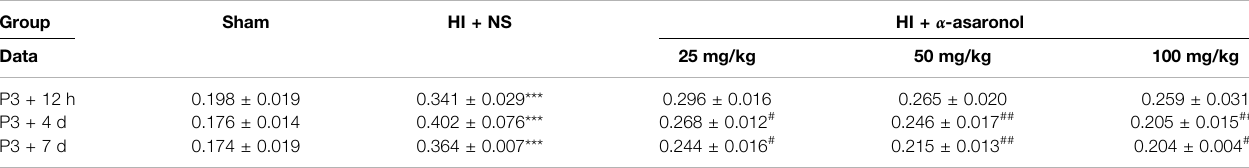
TABLE 1 | The glutamate concentration was determined by HPLC in the ipsilateral hemisphere at different time points after HI. Establishment of a standard curve of the glutamate standard. The linear range is from 1 to 200 μ g/ml. Correlation coef fi cient: r = 0.9996. All data are expressed as the mean ± SEM. ***p < 0.001 vs. sham.